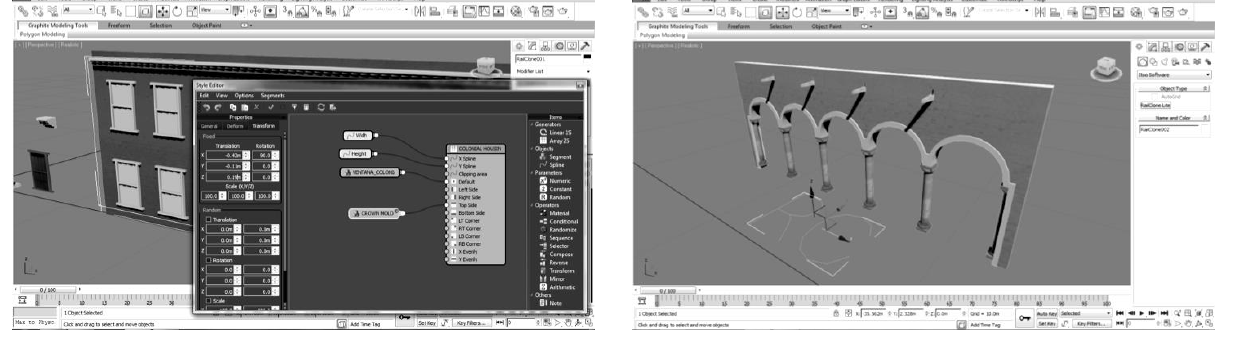
Figure 7. The “colonial-two-story-style” applied to a given wall.